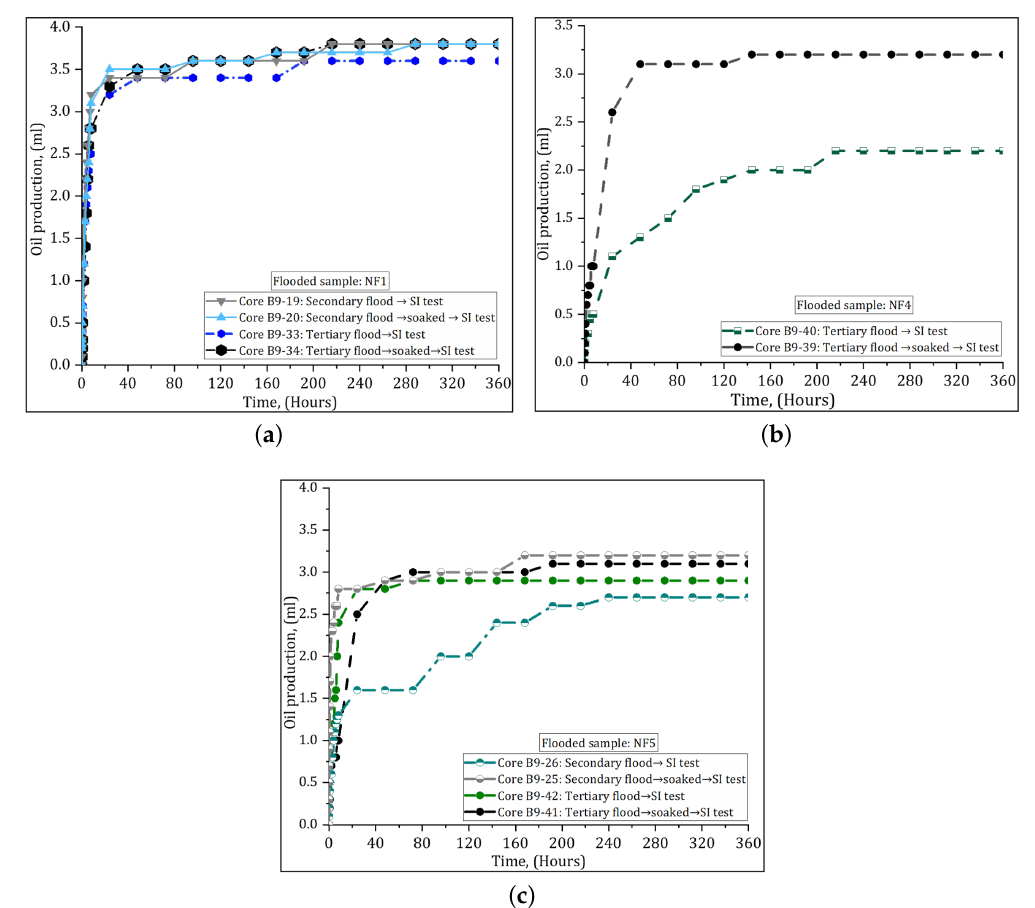
Figure A3. Spontaneous imbibition curves of the cores flooded with nanofluid, in which one of the two cores was soaked for 10 days at 40 ◦ C. Water progressively imbibed into the core displacing large amount of oil regardless of the soaking time or NPs exposure time on the rock surface. The differences between the rate of imbibition in some cores may be due to the accuracy of the measurements and core properties. ( a ) Core plugs flooded with NF1; ( b ) Core plugs flooded with NF4; and ( c ) Core plugs flooded with